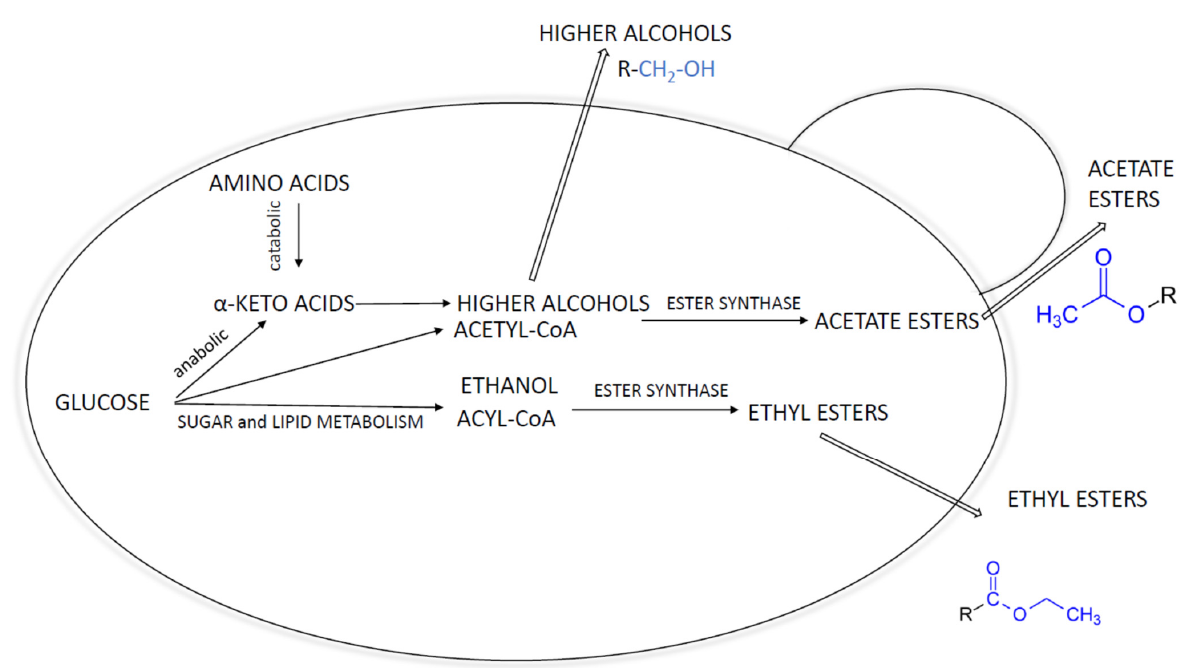
Figure 1. Formation of higher alcohols and esters.